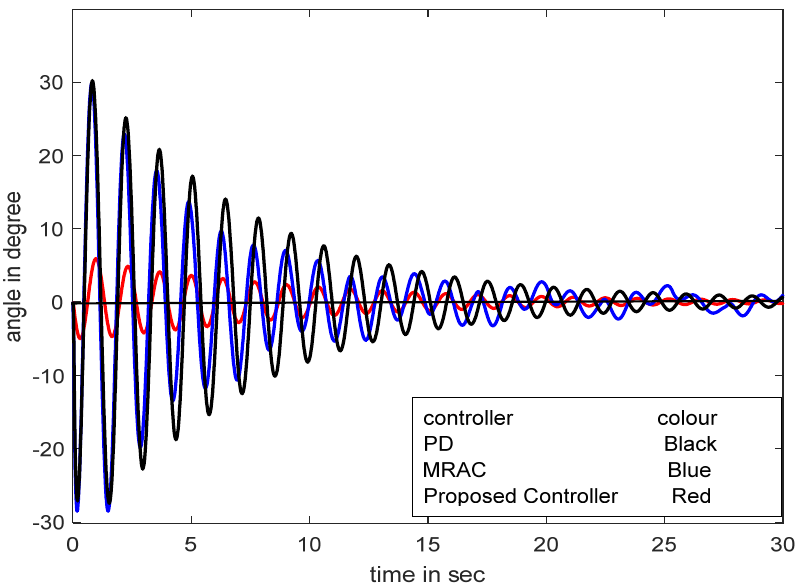
Figure 23. Design of SFMRAC for swing angle control in MATLAB Simulink.